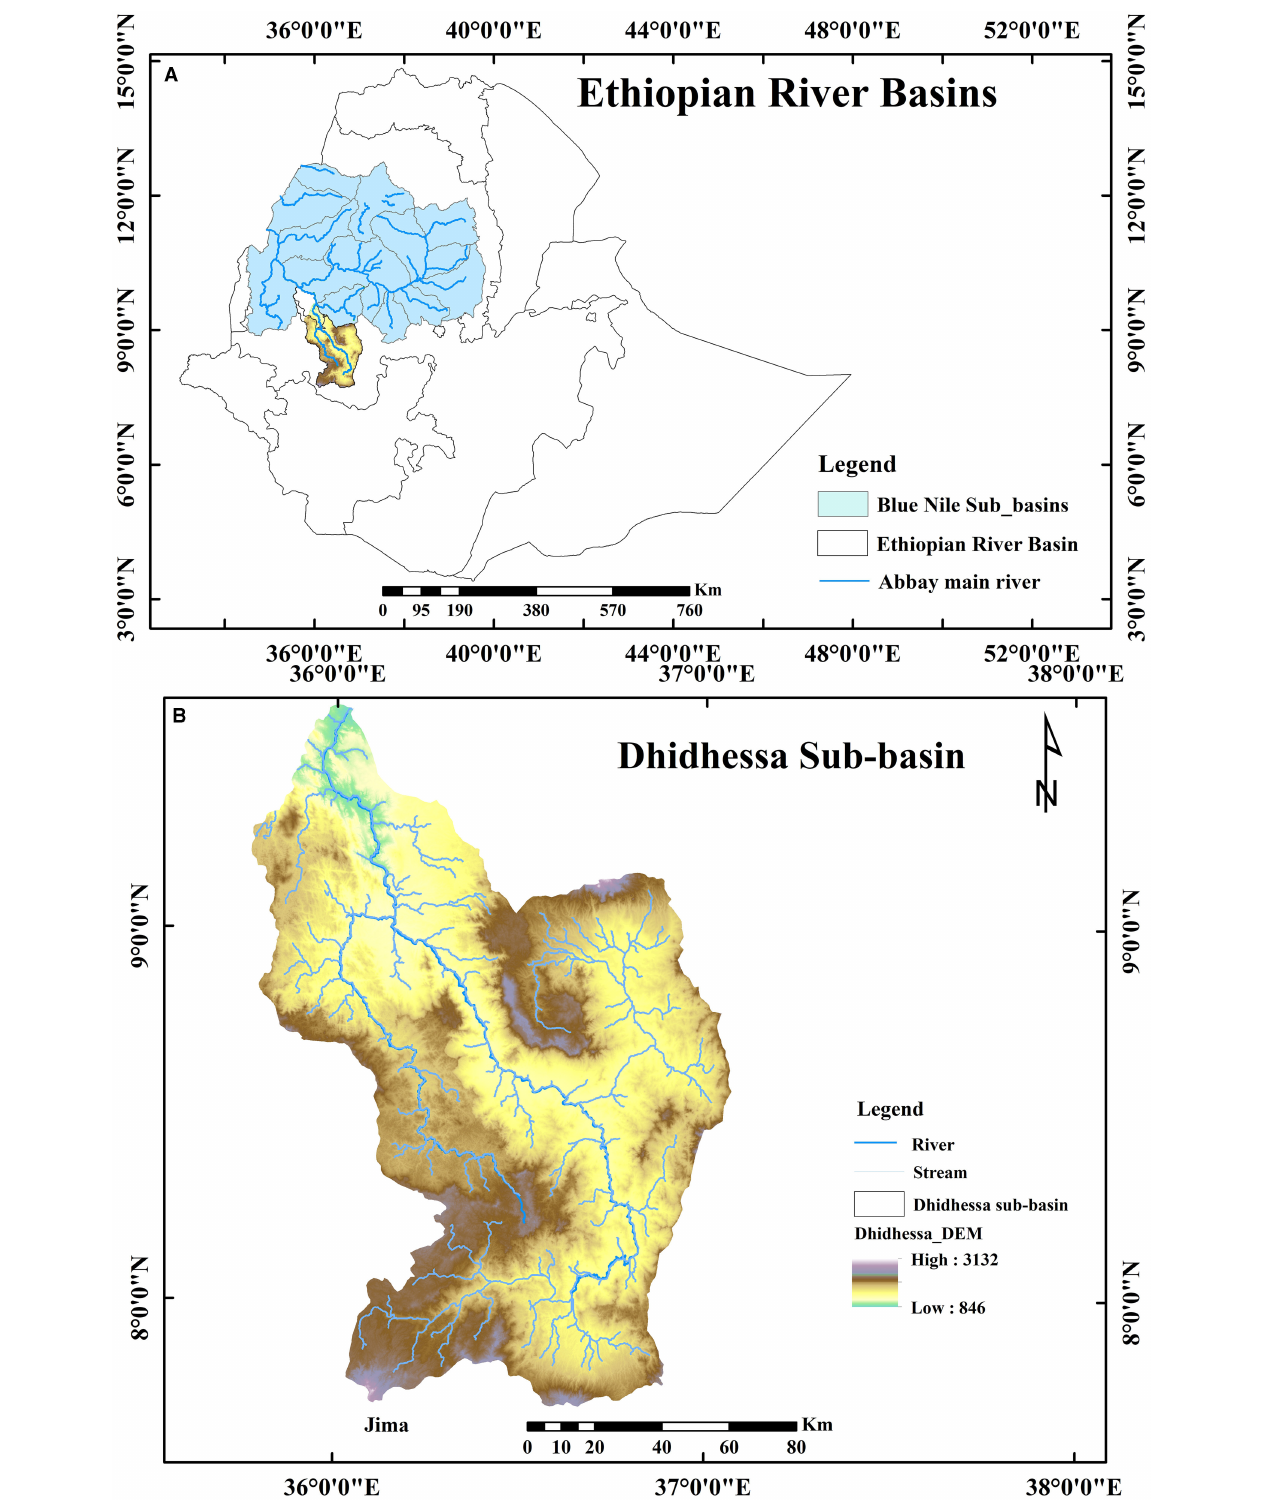
FIGURE 1 | Location map of the study area (A) Ethiopian river basins and (B) Dhidhessa sub-basin.